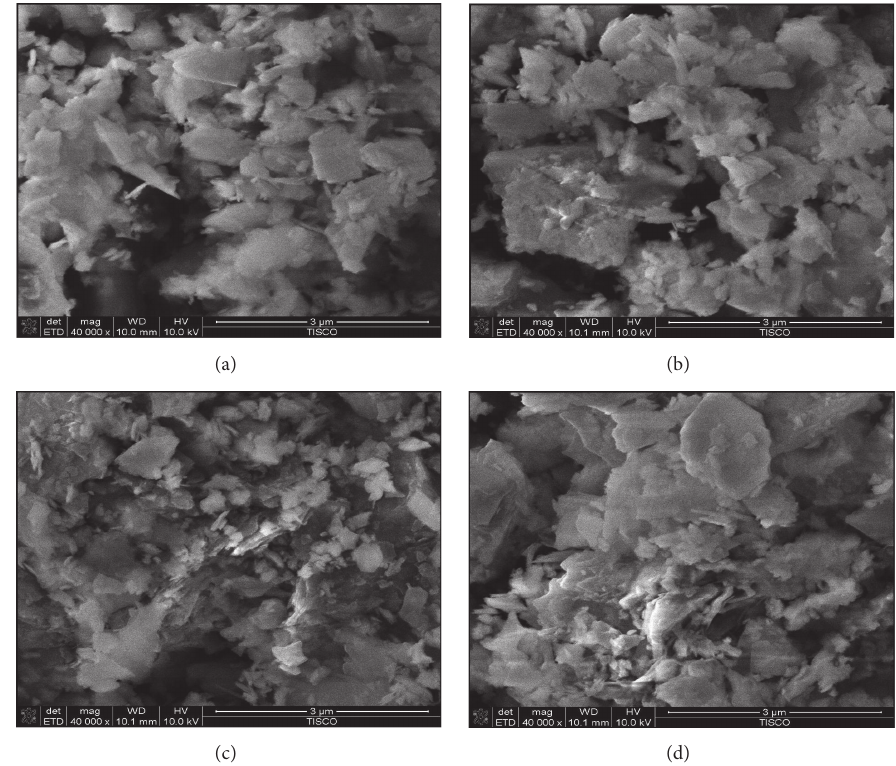
Figure 11: SEM images of samples reduced for (a) 1h at 400 ∘ C, (b) 2.5 h at 400 ∘ C, (c) 0.5 h at 500 ∘ C, and (d) 2h at 500 ∘ C.